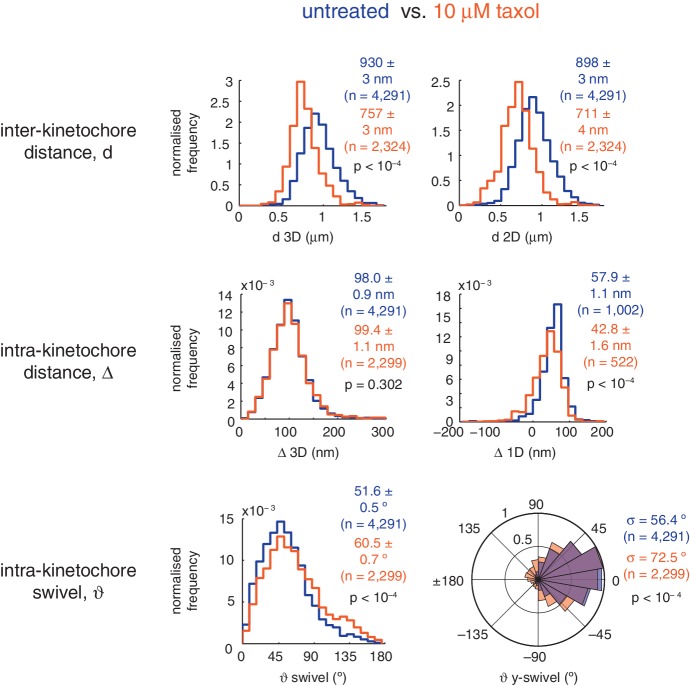
Effect of Taxol on inter- and intra-kinetochore distance and swivel.Distributions of inter-kinetochore distance (d; top row) in 3D (left) and 2D (right), intra-kinetochore distance (Δ; middle row) in 3D (left) and 1D (right), and intra-kinetochore swivel (ϑ; bottom row) in 3D (left) and within the xy-plane (ϑy-swivel, right) for untreated cells compared with 10 µM taxol. Values given are medians ± standard error, except for ϑ y-swivel where distribution standard deviations are given. All medians are statistically different between treated and untreated (p < 10–4), except for Δ 3D (p = 0.302).